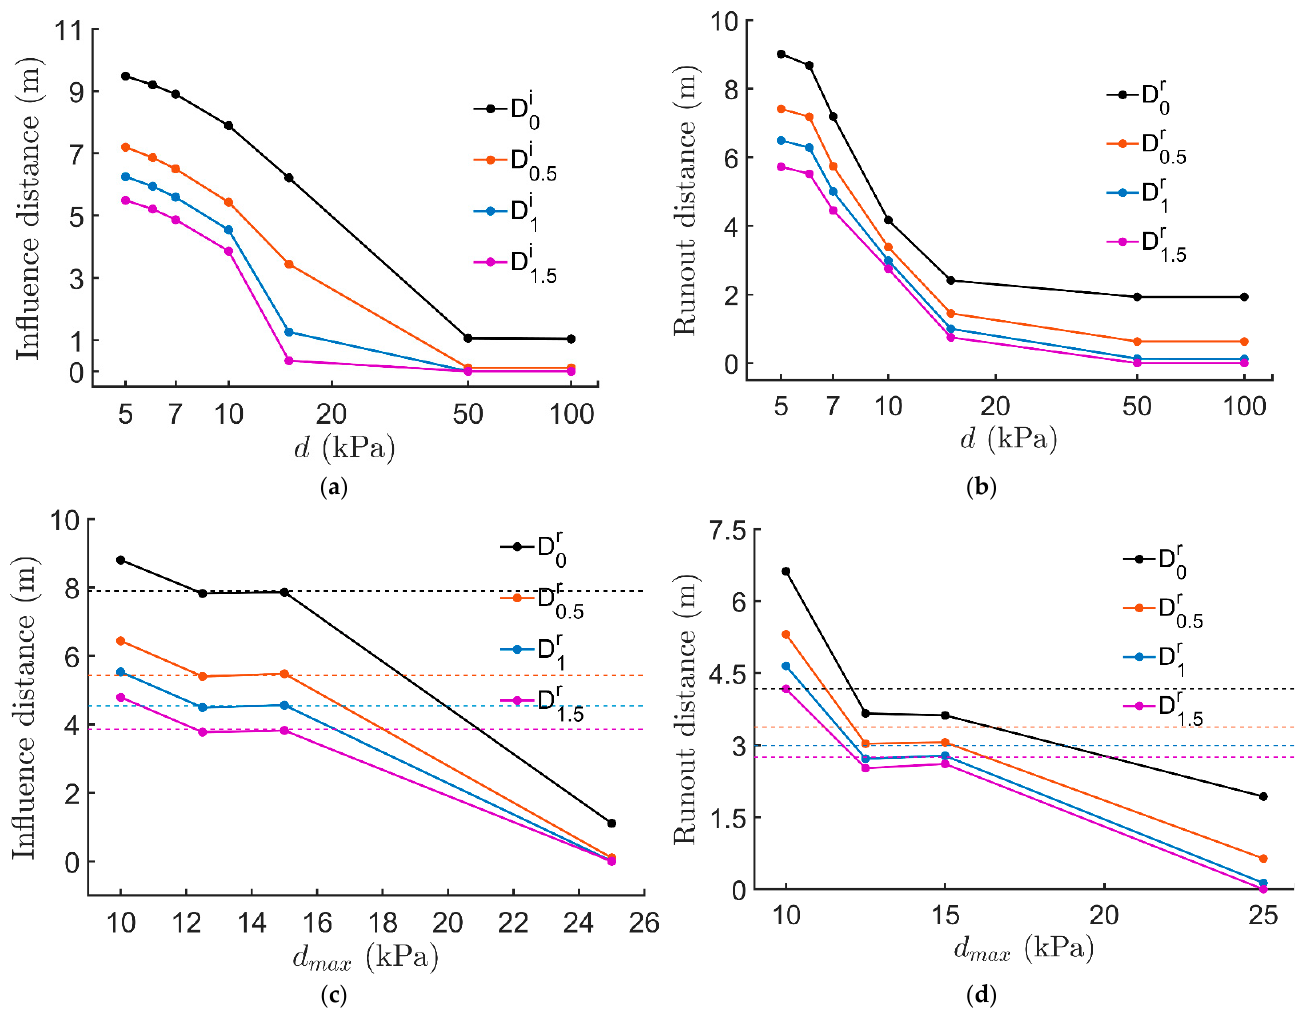
Figure 12. Variation of influence distance and runout with different cohesion in uniform and layered slopes: ( a ) different influence distances in uniform slopes; ( b ) different runout distances in uniform slopes; ( c ) different influence distances in layered slopes; ( d ) different runout distances in layered slopes. Table 2. Parameters used for the layered